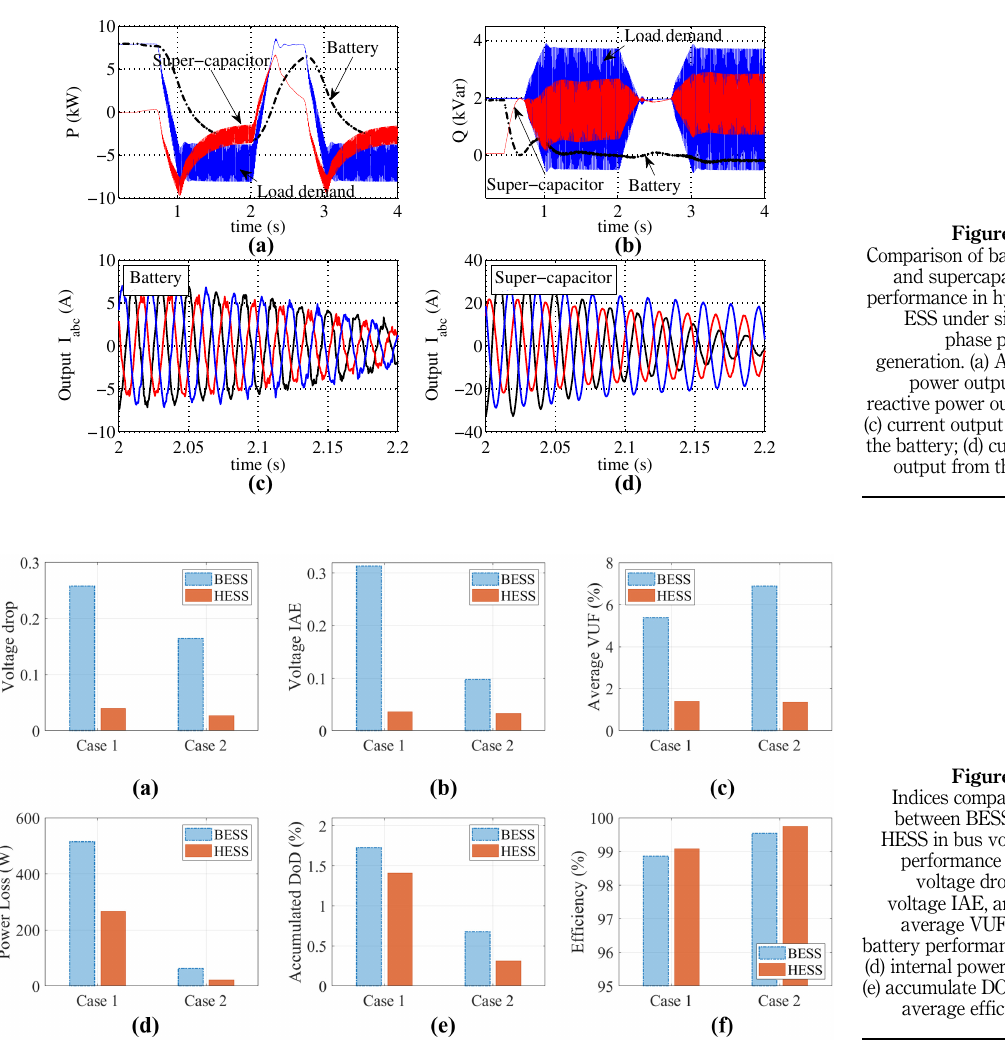
Figure 11. Comparison of battery and supercapacitor performance in hybrid ESS under single- phase power generation. (a) Active power output; (b) reactive power output; (c) current output from the battery; (d) current output from the SC